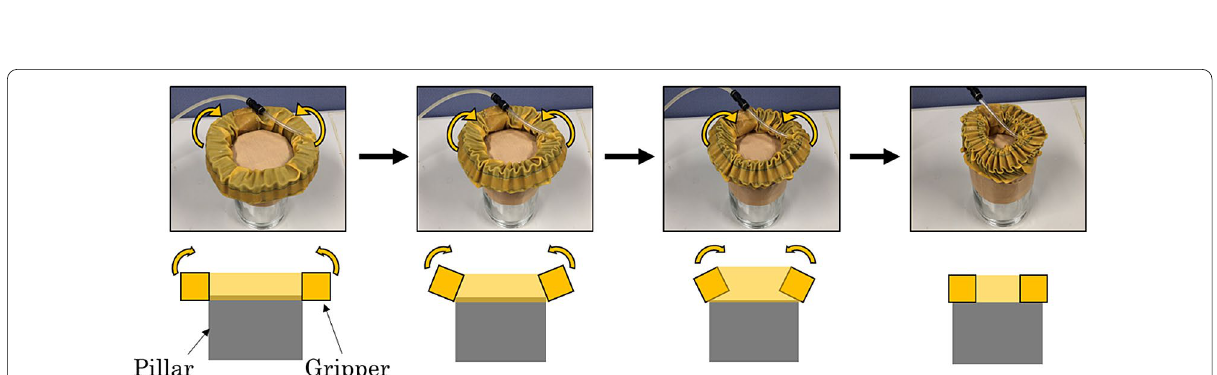
Fig. 10 Twisting motion of the gripper when its bottom contacted the top of a pillar. When the inside air of the gripper was evacuated, the upper part of the gripper continued to contract even after the bottom part contacted the pillar so that the gripper twisted until